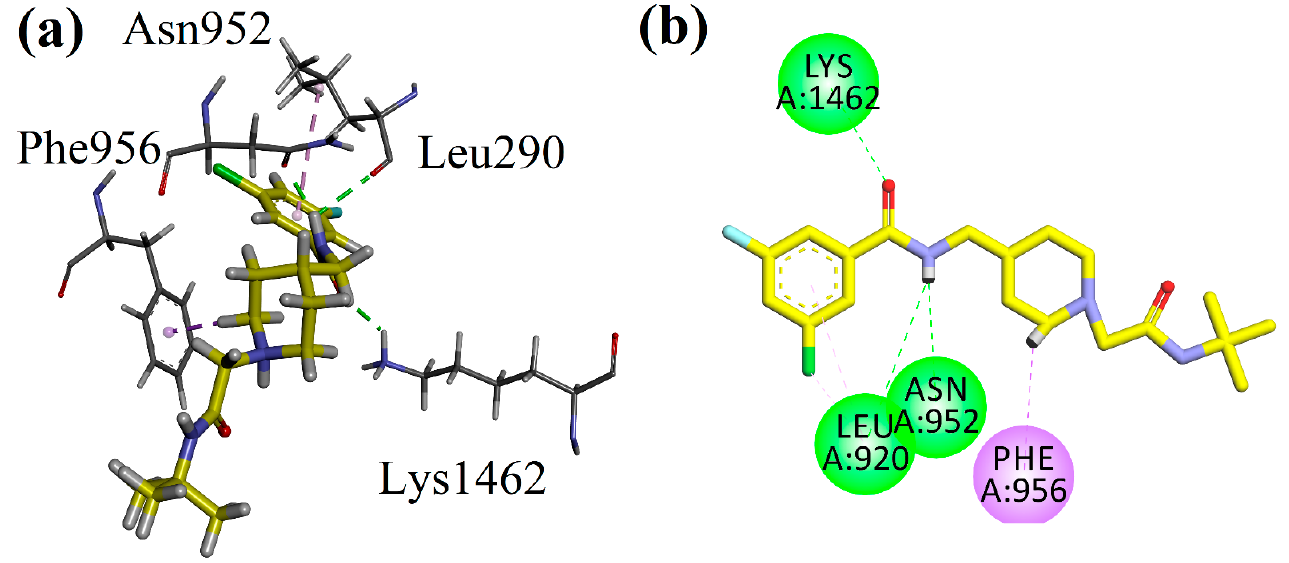
Figure 4. The 3-D/2/D interaction plots of native ligand in the binding site of 6KZP.